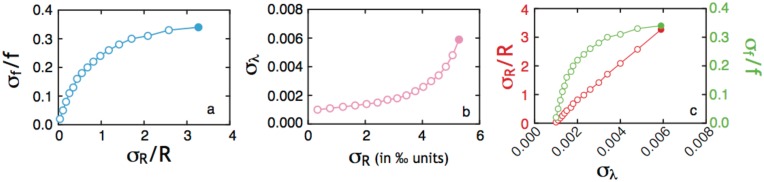
A series of frames (A–C) describing the origin and sensitivity of the controls on the resultant error in δ34S and 33λ plotted in Figures A2, A3. For this analysis, 34ε is set to 15.3‰ to be consistent with the reductive branch of the DsrAB experiments, the analytical precision of an isotope measurement is 0.2‰ in δ34S and 0.008‰ in Δ33S, and f is allowed to vary from 0.6 to 0.9 in 0.02 increments (noted by circles). This range in f is chosen to reflect the experimental range, and the circle is filled where f = 0.9. In (A), the covariance of the relative error in f (σf/f) is show to correlate with the error in the relative isotope ratio, σR/R. As the calculated error in the R derived from the Rayleigh equation (σR) increases, the consequence is an increase in the error in 33λ (B). Finally, the relationship between the errors in both f and R, as they contribute to the error on 33λ, are presented in frame C. Frames B,C do not approach the origin as a result of f not approaching the limits of 0 and 1, and also due to the multivariate nature of the propagation.